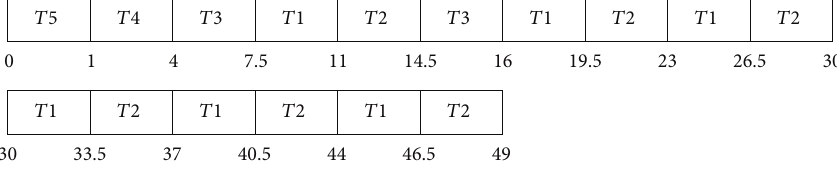
Figure 9: Gantt chart using VBRR scheduling